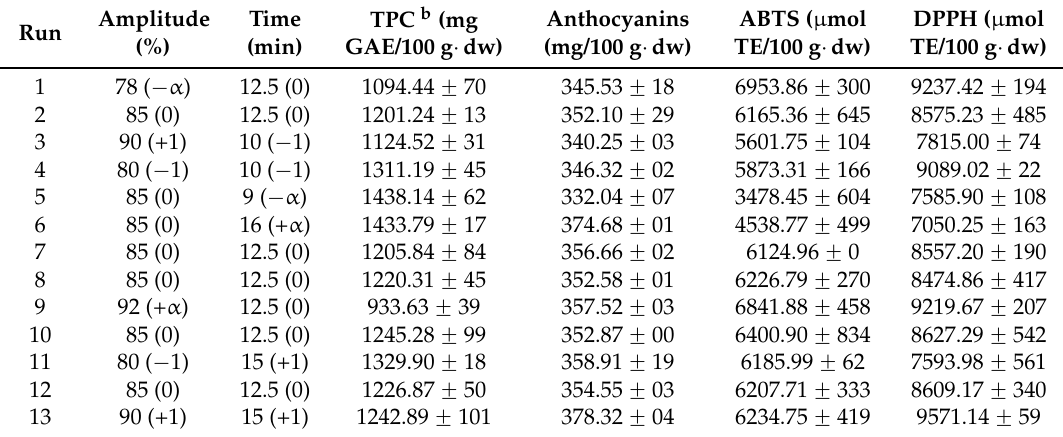
Table 1. Combinations of amplitude and time with their coded terms obtained from RSM and their respective values of TPC, anthocyanins and antioxidant activity a .